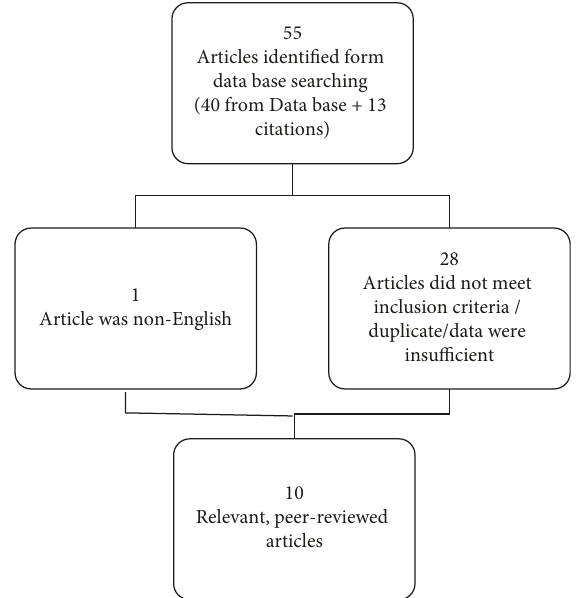
Figure 1: Flow chart of the search and the selection of studies for analysis. Source: